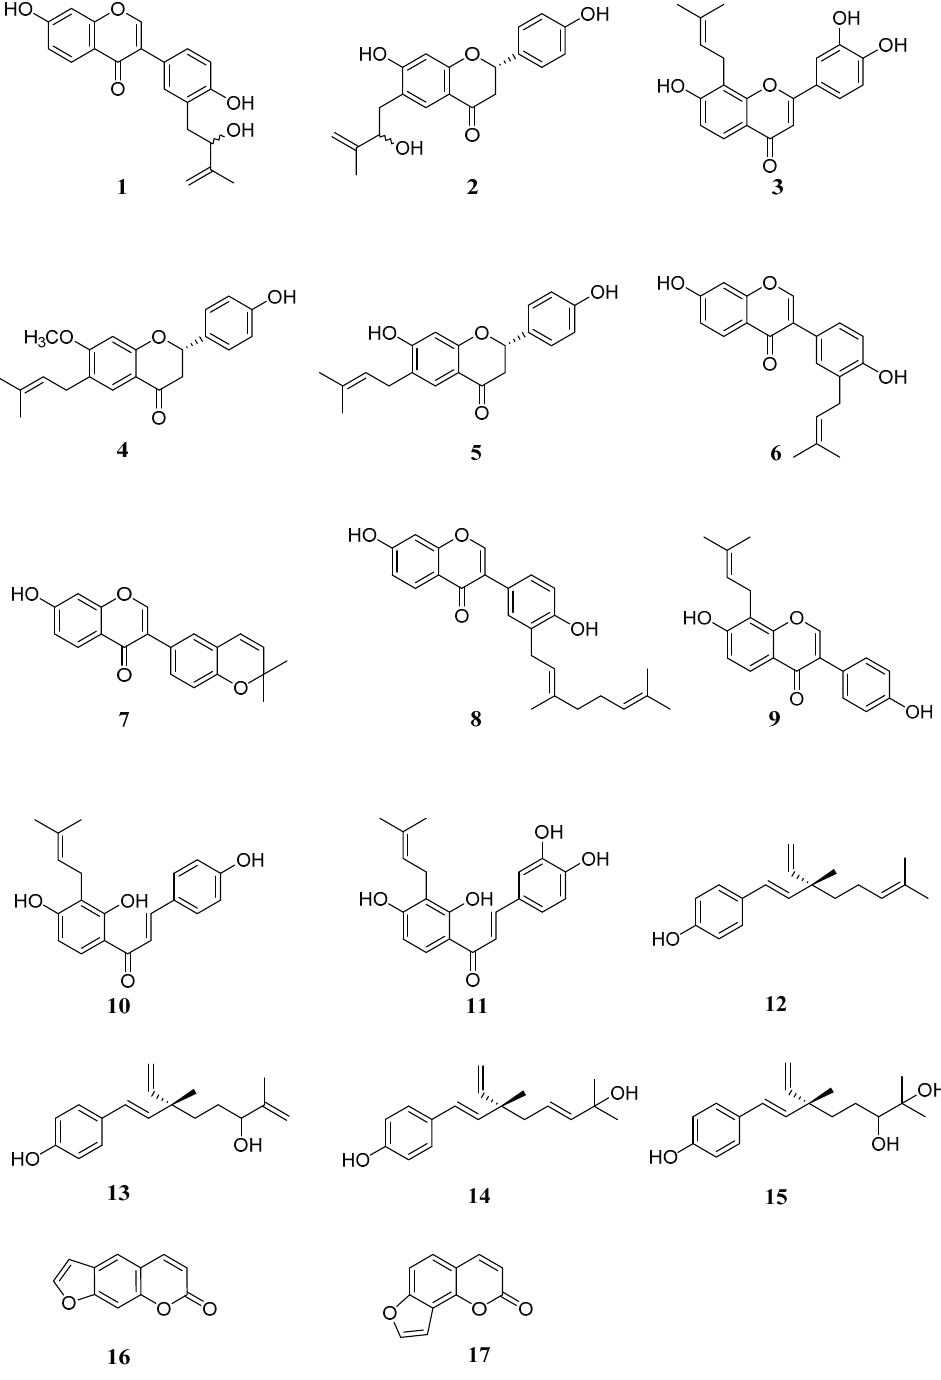
Figure 1. Structures of compounds 1 – 17 isolated from P.